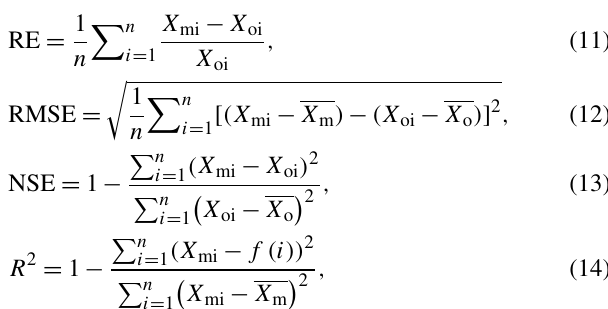
Figure 2. Intra-day distribution of normalized LE, R n , R s , R e , and PET and the values from the sine and Gaussian